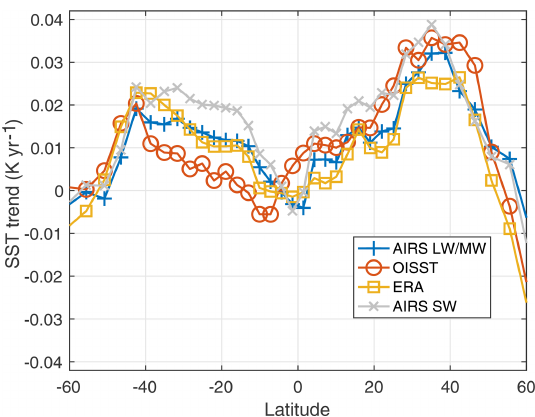
Figure 16. Latitude dependence of the linear trend in the AIRS re- trieved SST, OISST, and ERA-I SST. Also shown are the SST trends when only the AIRS shortwave channels are used to compute the